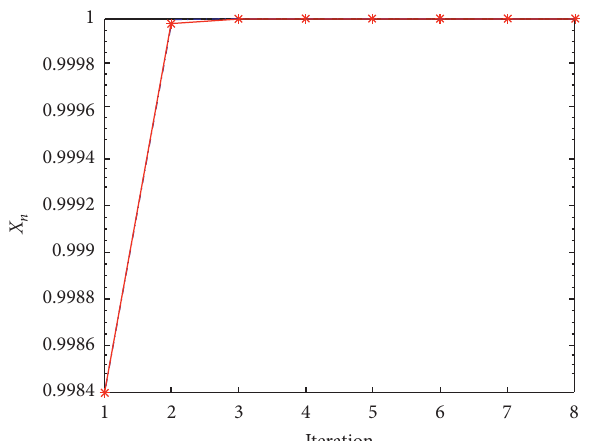
Figure 2: Convergence of iterative sequences generated by generalized M-iteration process and M-iteration process to the fixed point 1 of a mapping T defined in Example